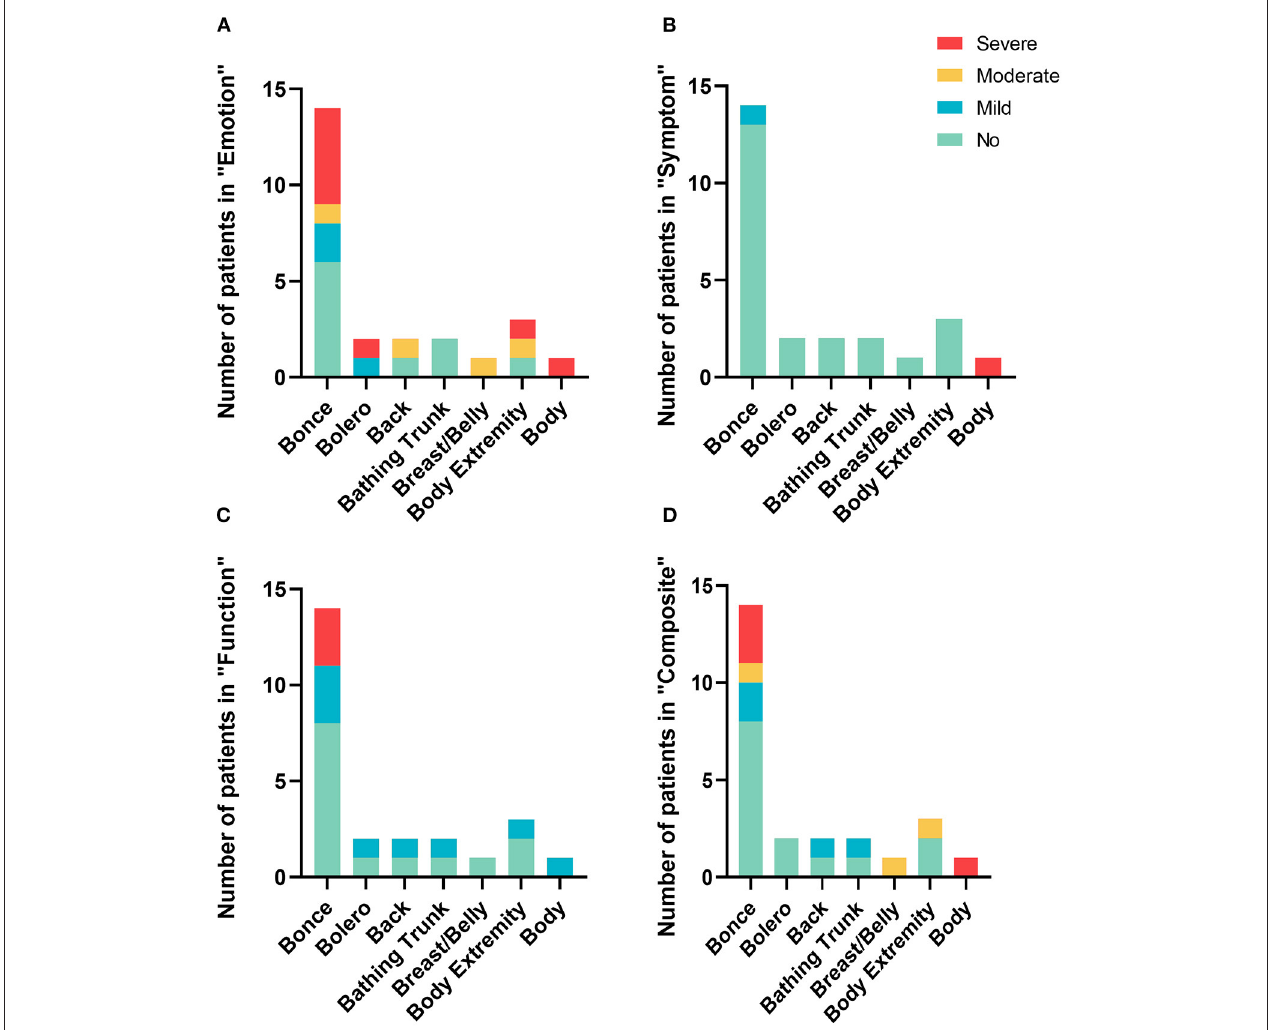
FIGURE 2 | The number of patients with LCMN in different degrees of QoL among “7B” rule. (A) In the subscale of “Emotion”. (B) In the subscale of “Symptom”. (C) In the subscale of “Function”. (D) In the subscale of